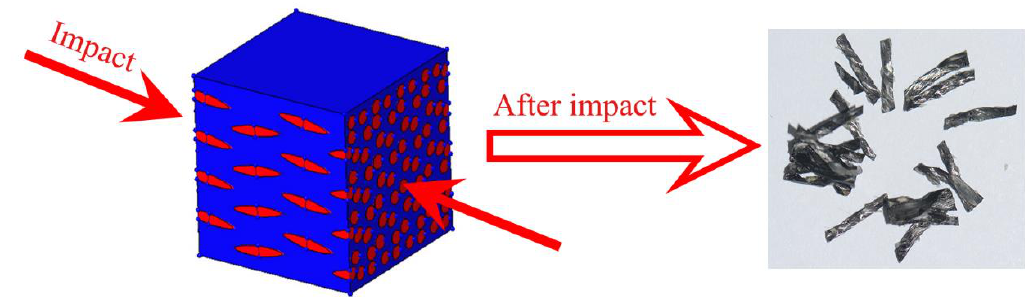
Figure 13. The typical fracture morphology for the 3D four-step braided composite under strain rate 1845 s − 1 after 210 cyclic hygrothermal aging days.